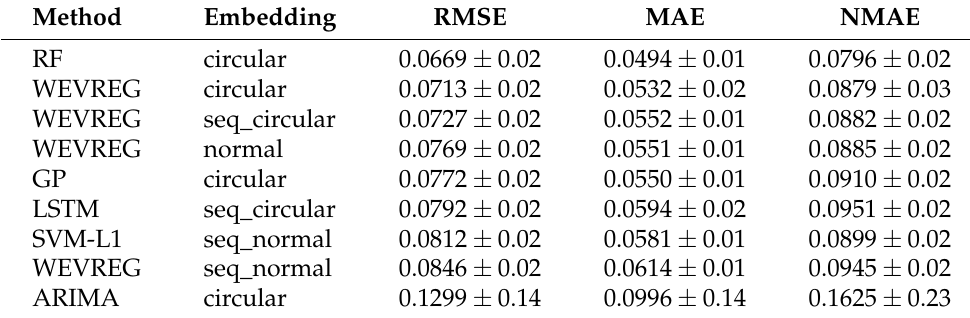
Table 6. Foot traffic prediction performance.